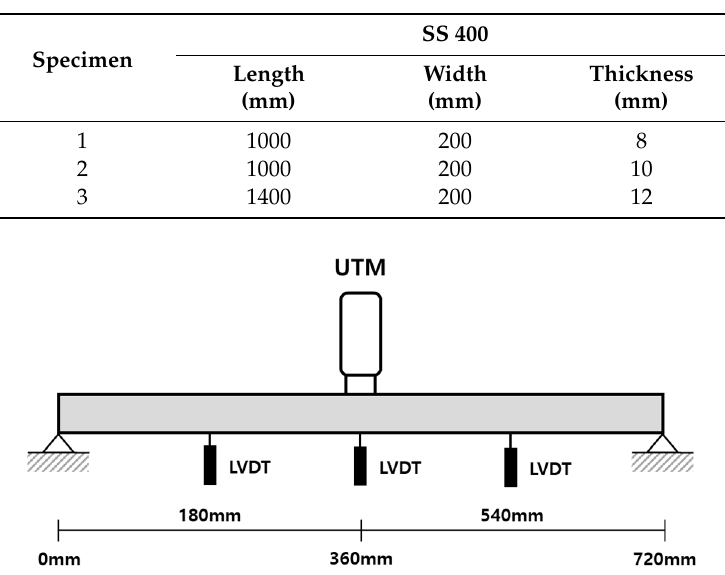
Figure 3. Linear variable differential transformer (LVDT) installation point.